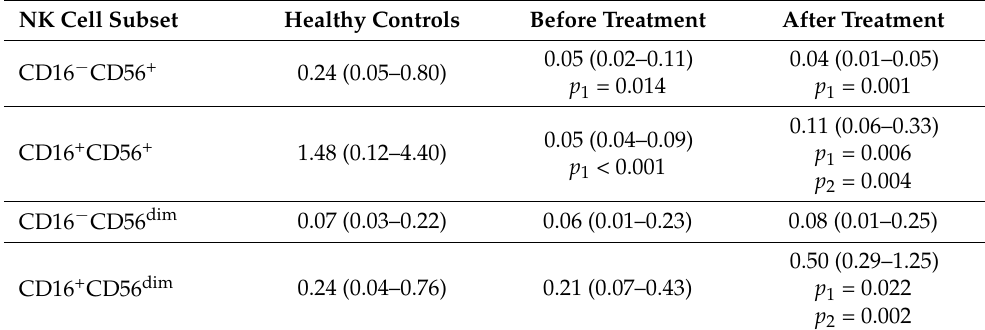
Table 5. CD8 expression by diverse NK cell subsets (%) in convalescent COVID-19 individuals before and after recombinant human IL-2 treatment (Me (IQR)).